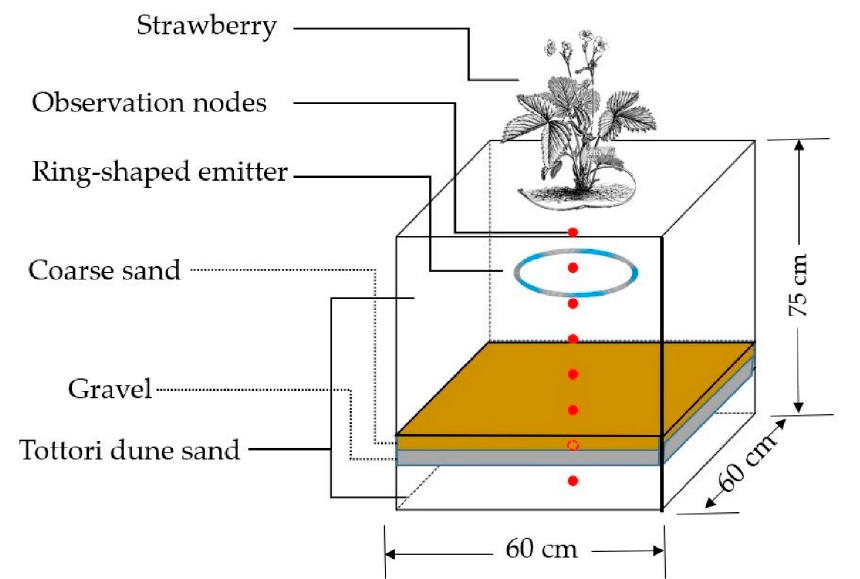
Figure 3. The simulation domain of the HYDRUS (2D/3D). The depths of the ring-shaped emitter and CB were varied.